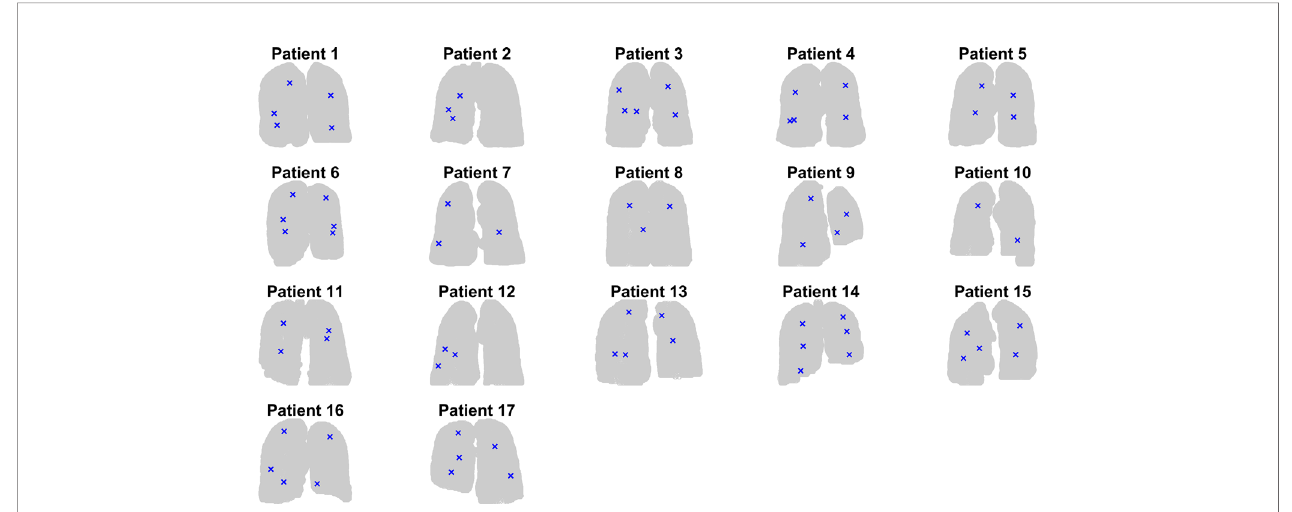
FIGURE 3 | Graphical representation of the location of the intraoperatively implanted fi ducial markers on coronal view for each of the 17